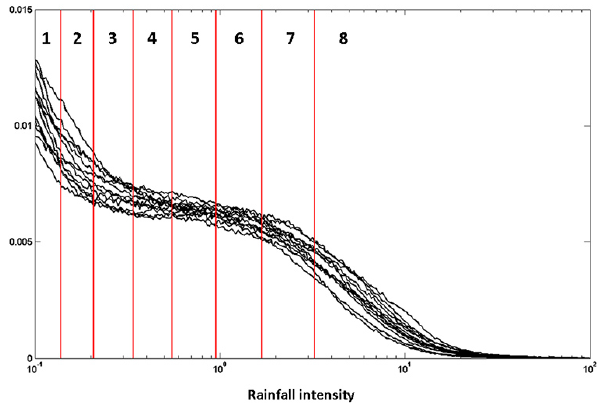
Figure 3. Normalized frequency of occurrence of accumulated pre- cipitation intensity (mm/3h) for the 12 radar stations based on the entire data record (2000–2010). The vertical lines show eight bins chosen in such a way that the number of observations is roughly similar in each intensity bin.